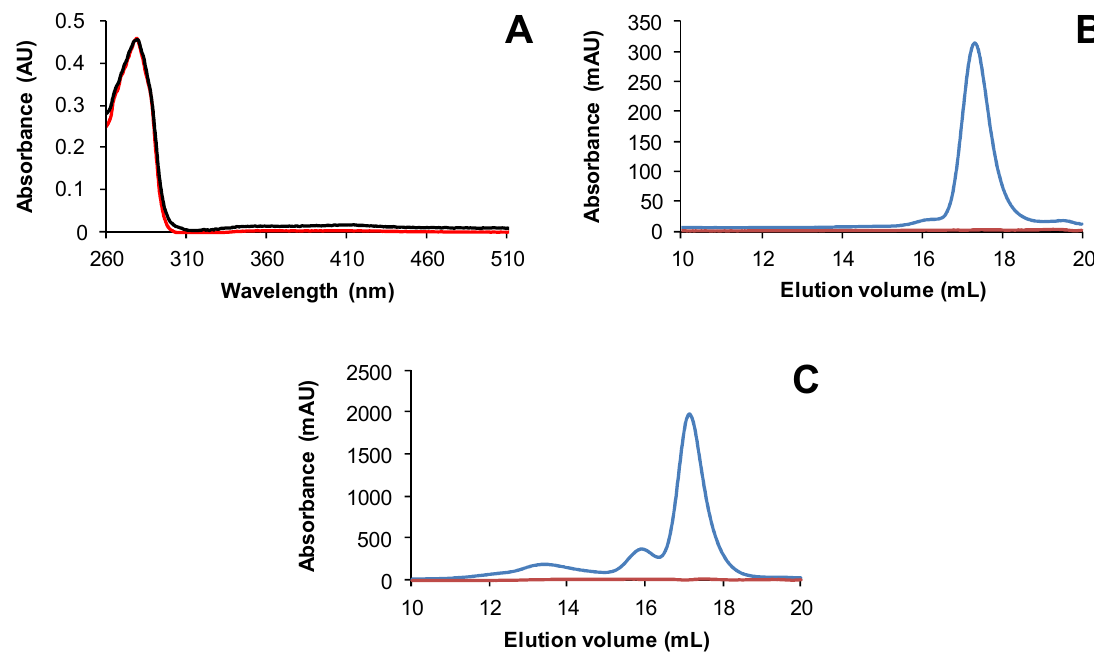
Figure 3. Monocysteinic variants of Arabidopsis TRXo2 isoform are mostly apo-monomers. UV–visible absorption spectra of His-tagged recombinant TRXo2 C37S (red line) and C40S (black line) ( A ) recorded after an anaerobic purification in 30 mM Tris-HCl pH 8.0. Analytical gel filtration of His-tagged recombinant TRXo2 C37S ( B ) and C40S ( C ) purified in anaerobic conditions, was performed by